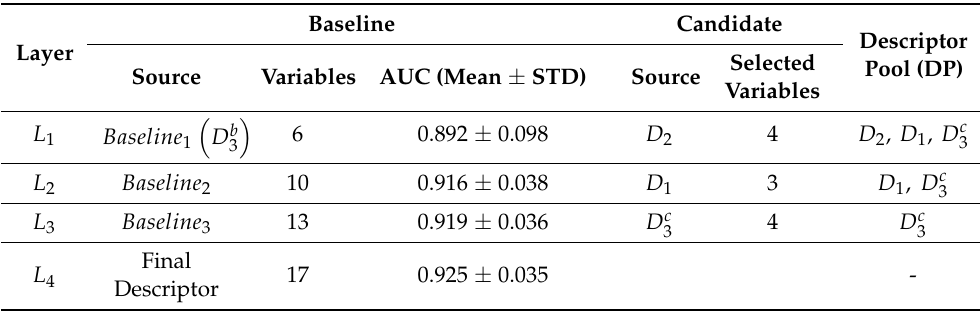
Table 6. All results of the MGHM over the polyp dataset. Descriptor pool represents the current candidates and its sequence in each layer. Baseline 2 and Baseline 3 are two new descriptors generated by the baselines and the complements of their previous layers.